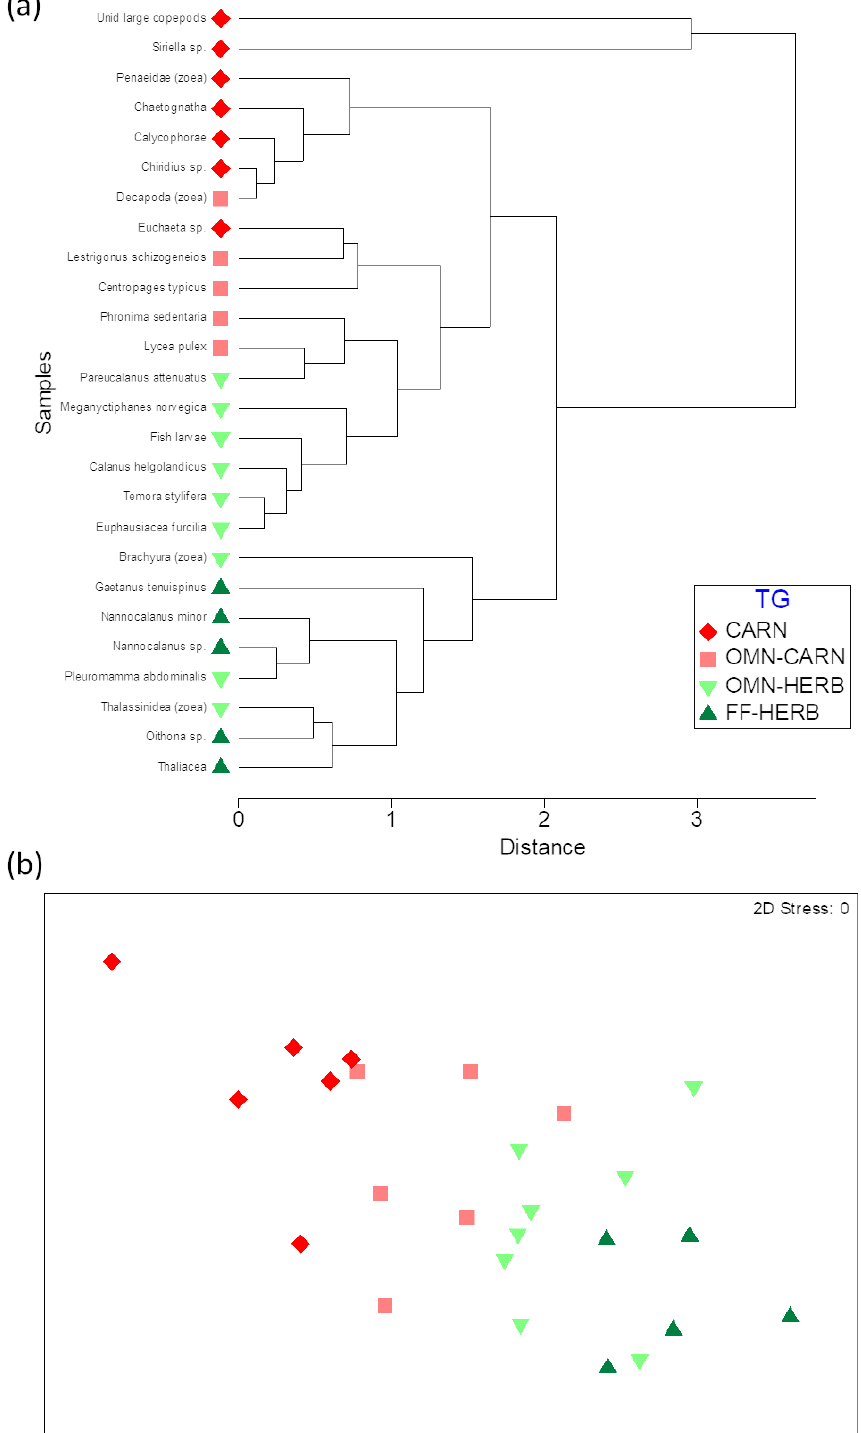
Figure 4. Cluster (a) and nMDS (b) analyses on the bivariate matrix of δ 13 C and δ 15 N values of dominant zooplankton taxa averaged for the whole sampling area. Colours indicate trophic groups as follows. FF-HERB: filter feeders–herbivores (dark green), OMN-HERB: omni- vores with preference towards herbivory (light green), OMN-CARN: omnivores with preference towards carnivory (orange), CARN: carni- vores